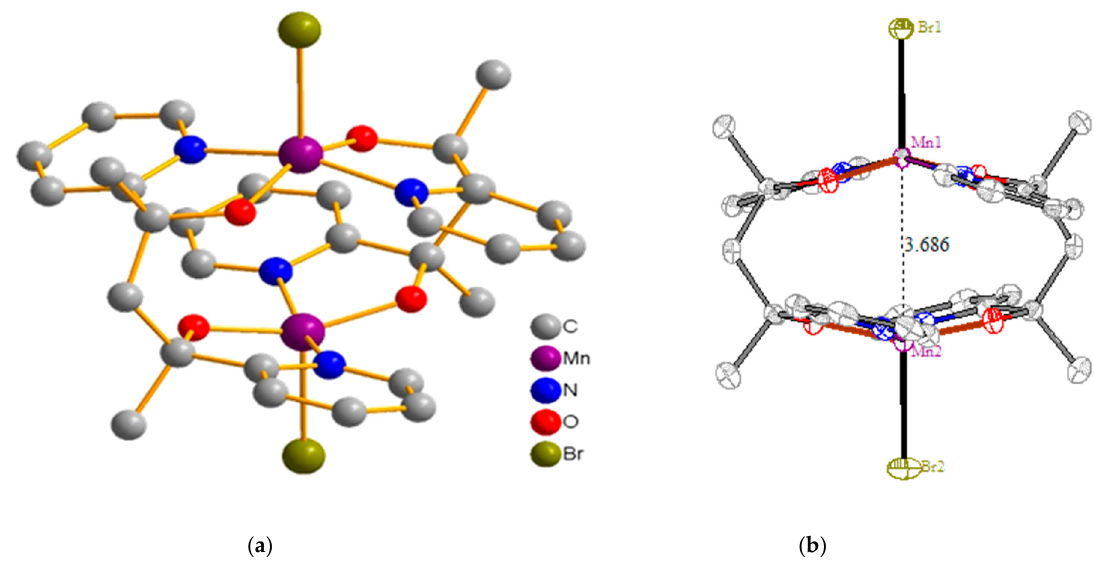
Figure 1. ( a ) Structural plot of compound 1 . ( b ) Side view of compound 1 , where the Mn–Mn distance is 3.686 Å. Table 2. Selected bond distances (Å) and angles (deg) of compound 1 .